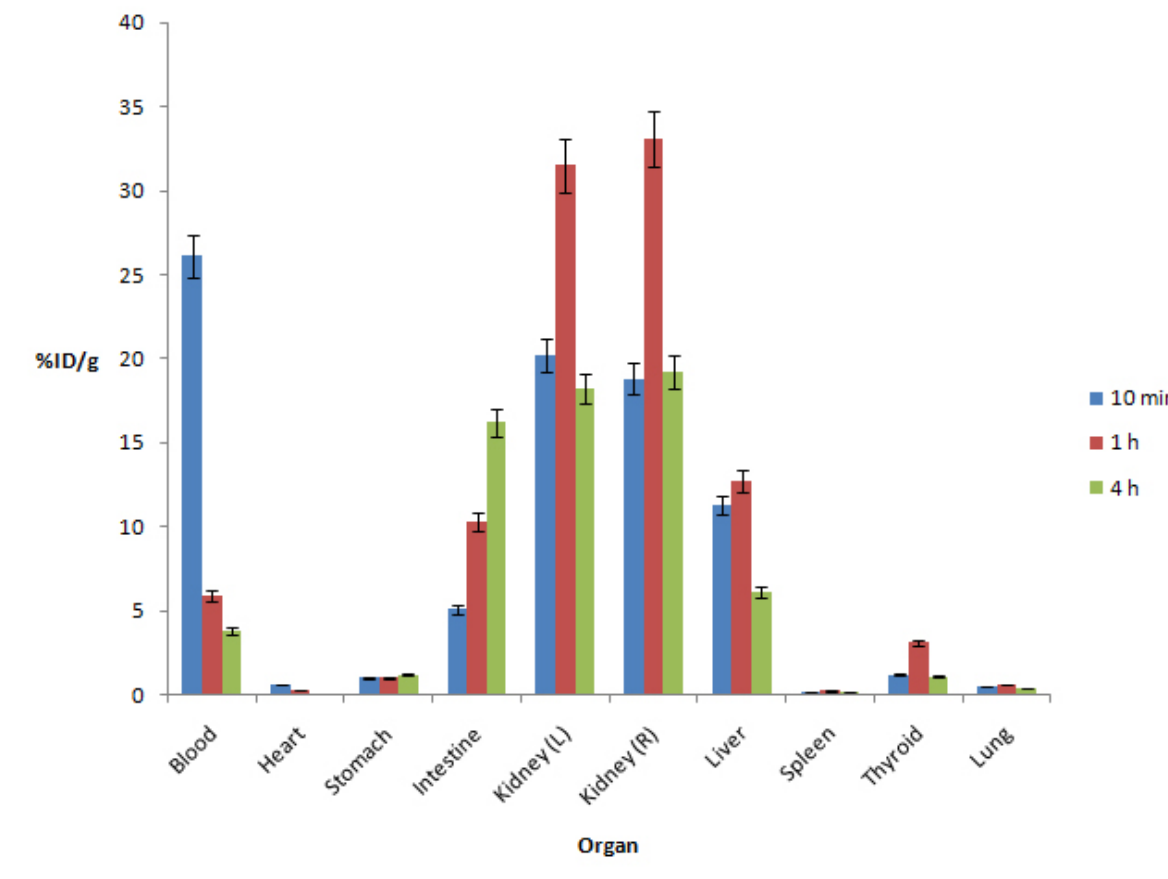
Figure 6. Biodistribution of F3.1.9 in mice at ten minutes, one and four hours. Data are presented as %ID/g ± SD and results are the means of groups of three animals. Values of p < 0.05 are considered statistically